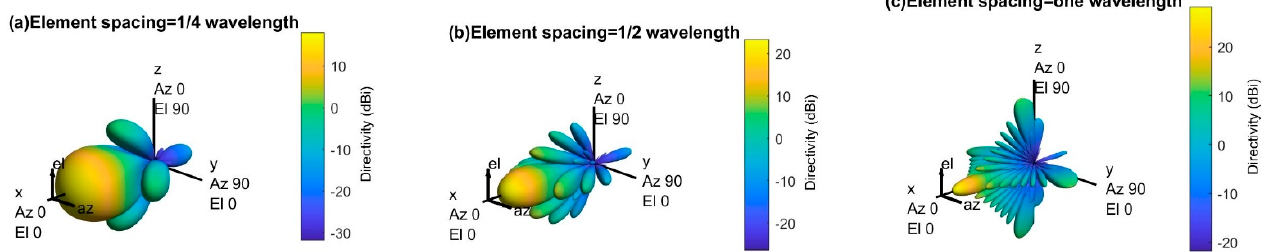
Figure 7. 3D radiation pattern of an 8-by-8 antenna array with different element spacing for 30 GHz operating frequency.